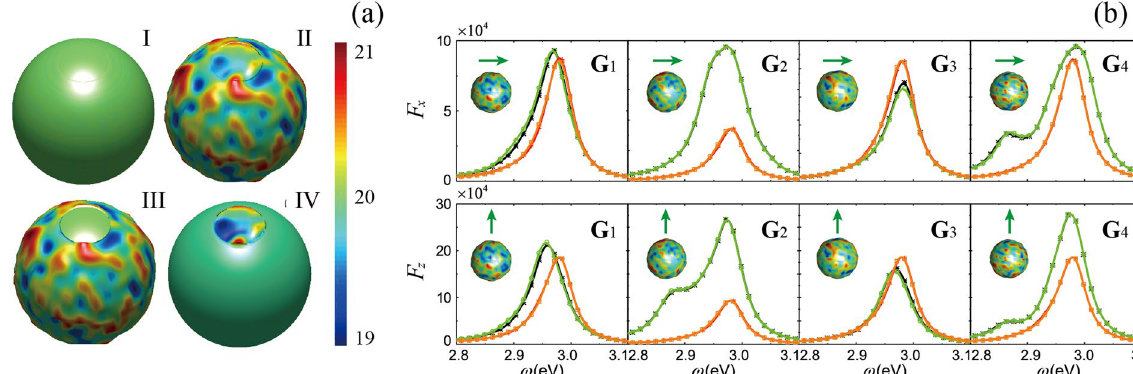
Figure 5. ( a ) Schematic diagram of a simulation group. Every simulation group contains four types of MNP: smooth MNP (I), rough MNP (II), smooth-rough MNP (III), and rough-smooth MNP (IV), as discussed in text. MNPs within a group use identical realization of the rough surface. ( b ) LDOS of four simulation groups G 1 − G 4 for x-oriented dipole (upper panels) and z-oriented dipole (lower panels). The green line with crosses and black line with stars indicate the results of rough and rough-smooth MNPs, respectively; the orange line with crosses corresponds to smooth MNPs and the red line with stars corresponds to smooth-rough MNPs. Inset: dipole orientation and rough MNP (model (II) in panel (a)) in each